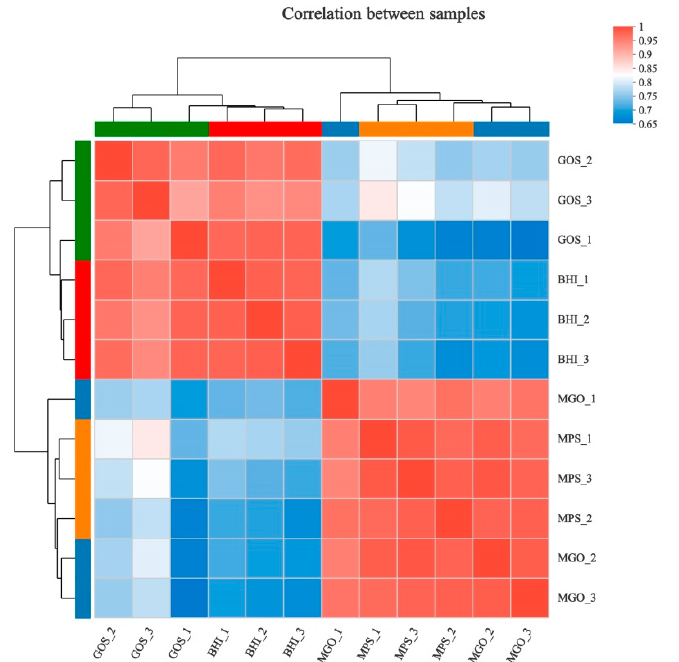
Figure 2. Clustering analysis of differentially expressed genes (DEGs) in culture of A. muciniphila with different prebiotics.